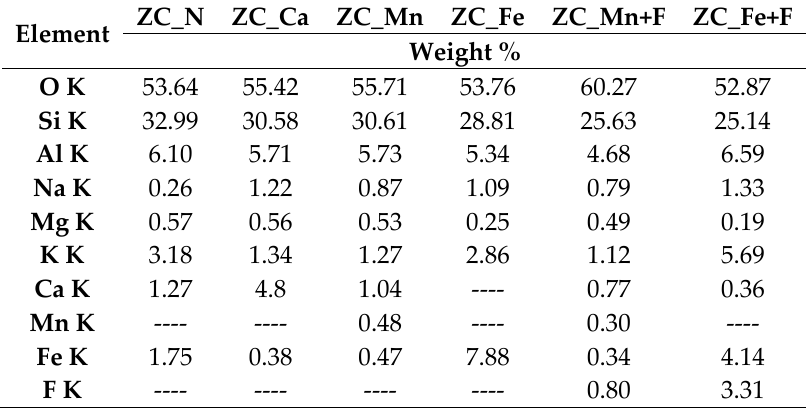
Table 2. Elemental composition of